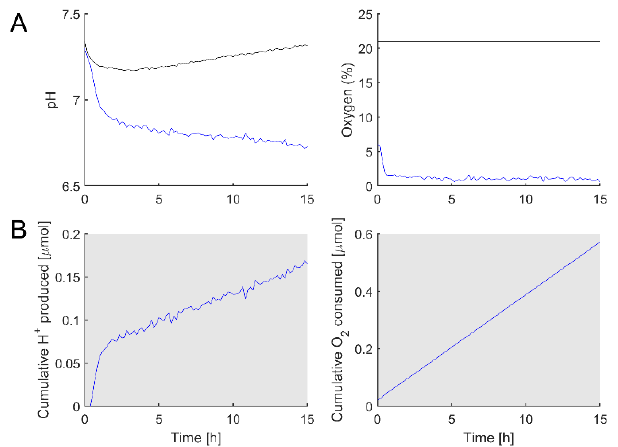
Figure 9. Using the method to study metabolism in primary myocytes freshly isolated from the mouse ventricle. ( A ) Time courses of pH and O 2 . A suspension of myocytes in media was probed for O 2 and pH over a period of 15 h, shortly after enzymic isolation from a mouse heart. Media contained 2 mM HEPES and 2 mM MES, 25 mM glucose, supplemented with 10% FBS, 1% penicillin–streptomycin mixture, 1% GlutaMAX, and 1% sodium pyruvate. ( B ) The cumulative H + production and O 2 consumption, calculated using Equations (7) and (8). Myocytes have a high oxidative metabolism, causing the rapid depletion of O 2 . Some degree of glycolytic metabolism was also noted. Mean of 3 technical repeats.